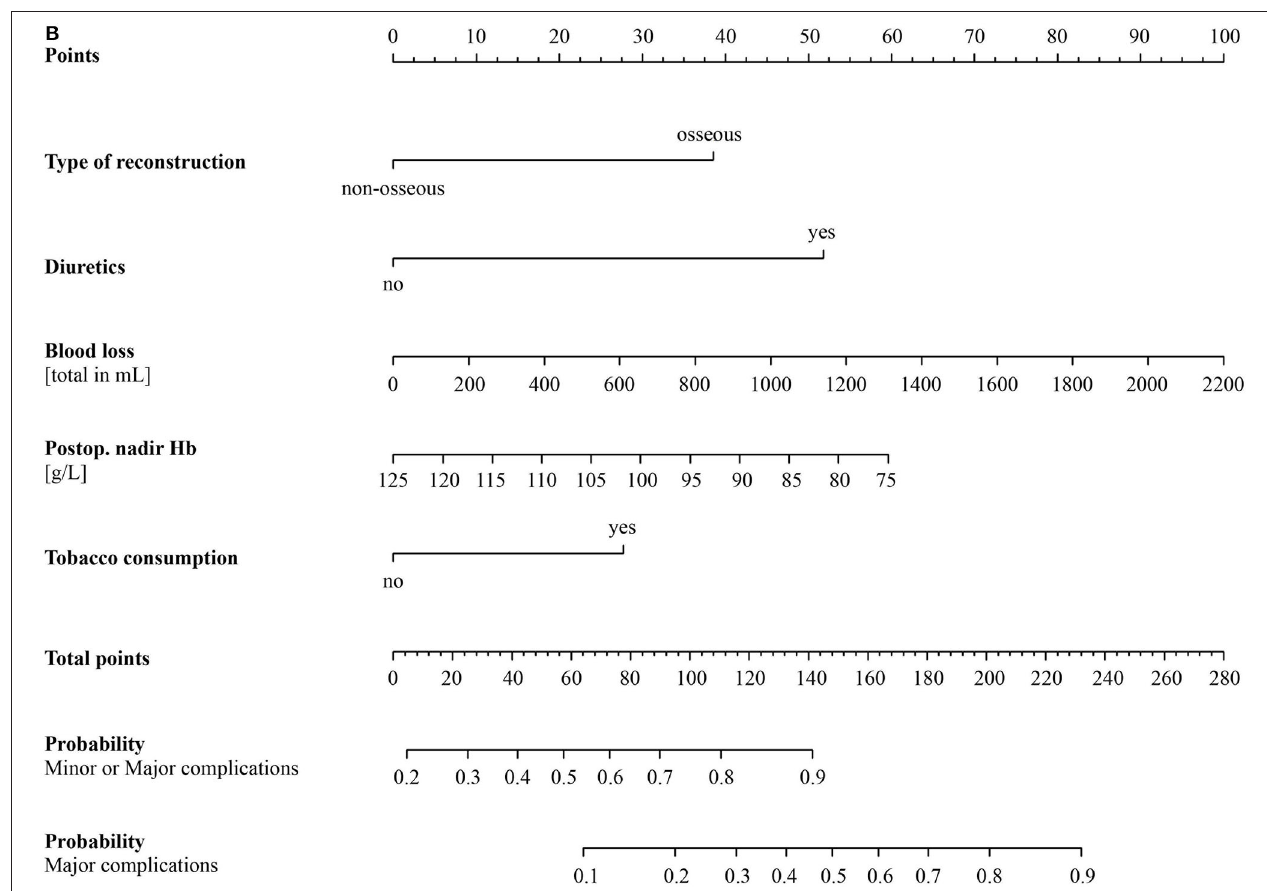
FIGURE 2 | (A) Nomogram of the logistic regression model for predicting the outcome “Relevant Systemic Complications.” (B) Nomogram of the ordinal regression model for predicting the risk categories of the outcome “Clavien-Dindo classification grade.” g/L, grams per liter; Hb, hemoglobin; mL,